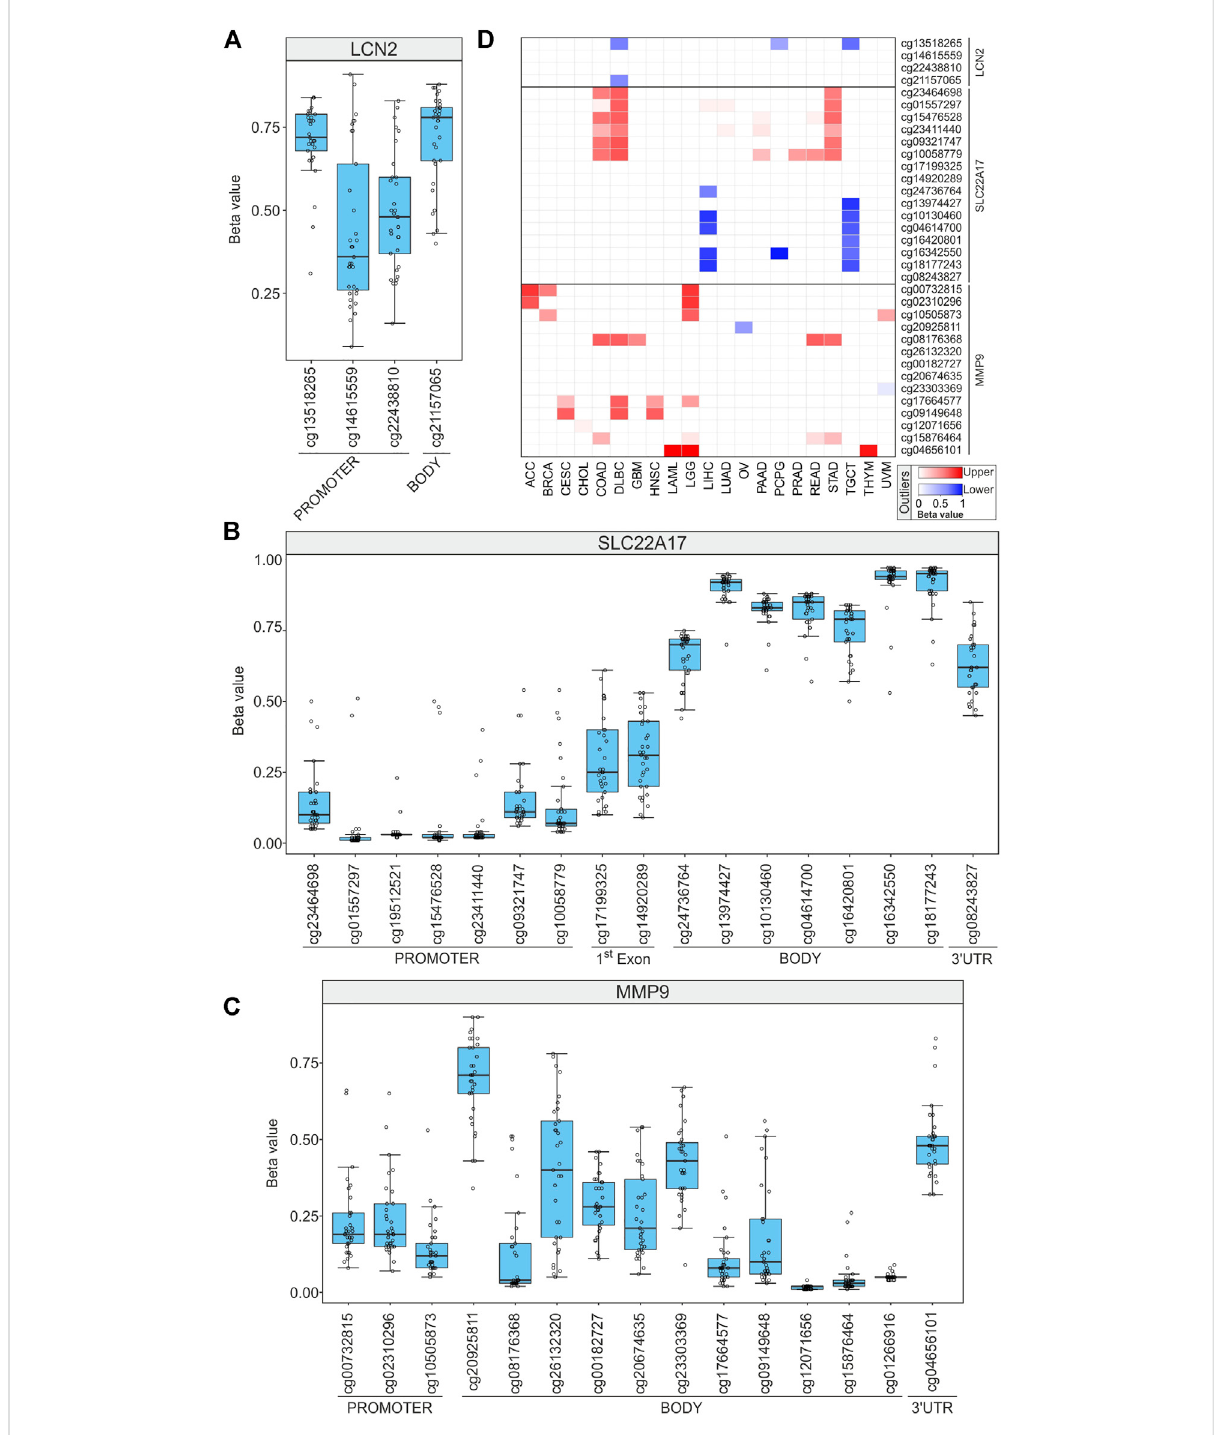
FIGURE 8 DNA methylation pro fi ling of LCN2 , SLC22A17 , and MMP9 in all tumor samples. (A – C) For each CG methylation probeset, the mean of methylation beta value is displayed for all tumor types (empty circles). (D) Heatmap showing the tumors in which the mean GC probeset beta value resulted lower (red) or upper (blue)